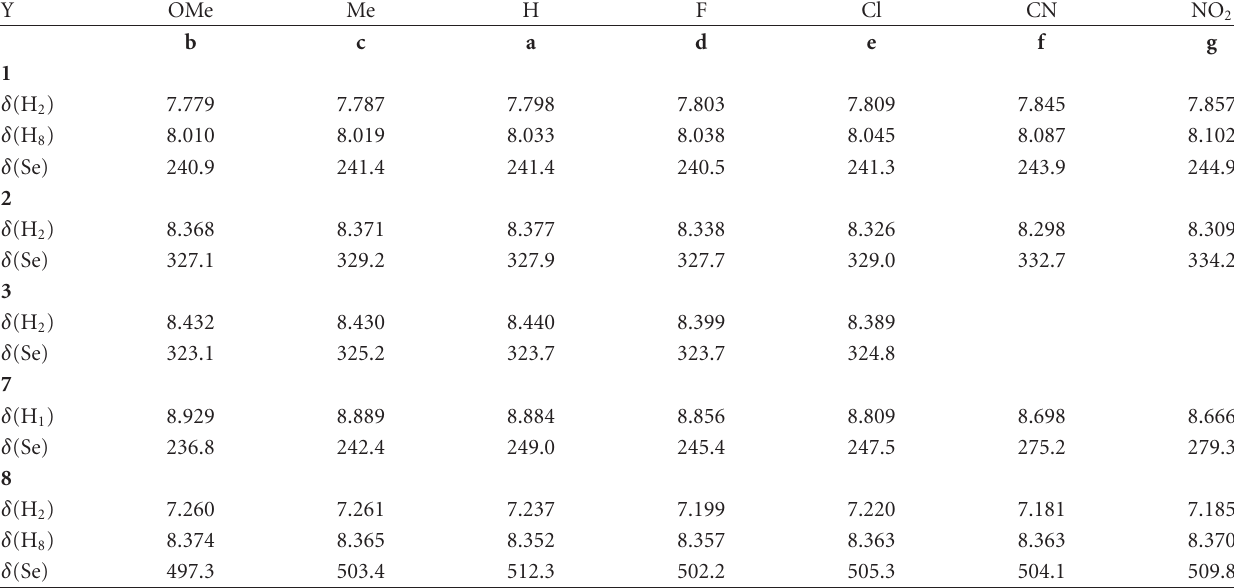
Table 2: 1 H and 77 Se NMR chemical shifts in 1 − 3 , together with those in 7 and 8 (a,b)